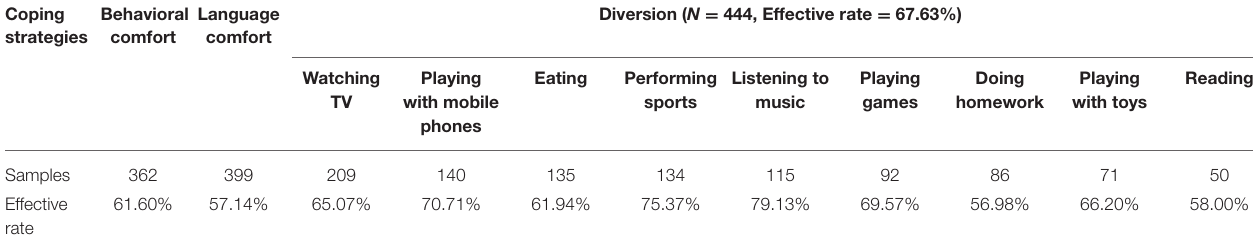
TABLE 2 | Informal coping strategies adopted by the parents of children with intellectual disabilities. Coping Behavioral Language strategies comfort